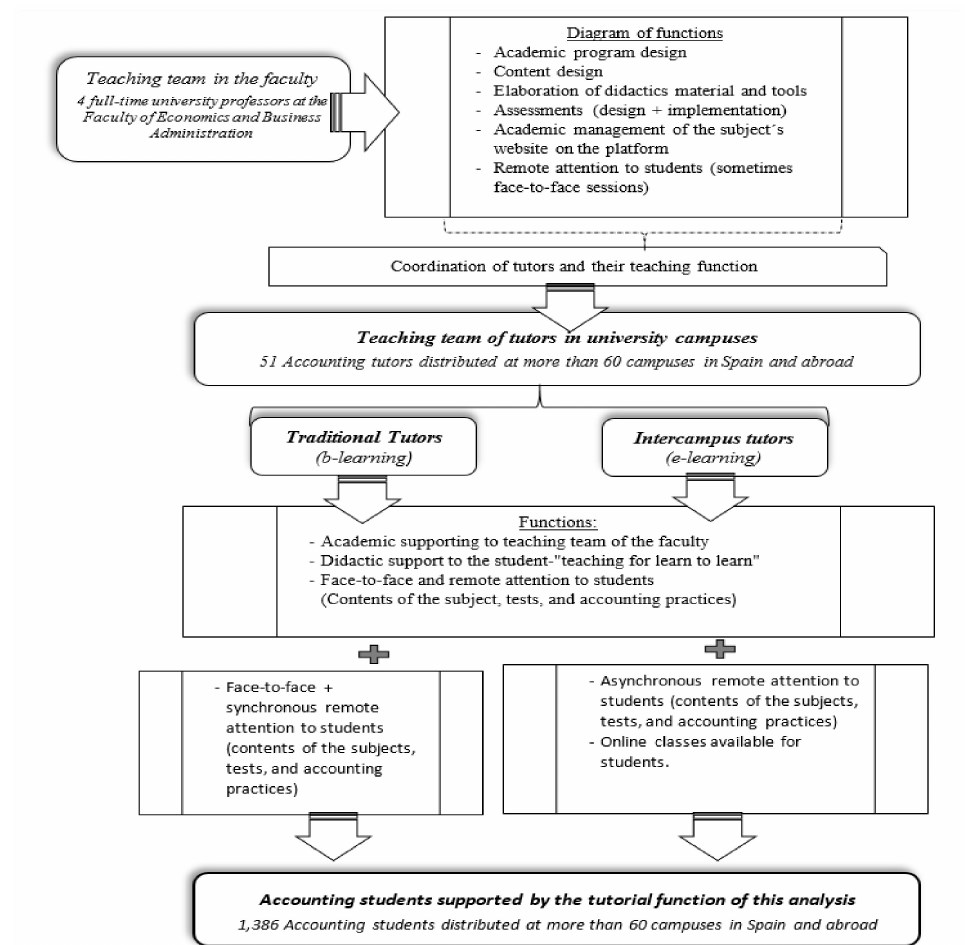
Figure 2. Educational model and tutor function in financial accounting and managerial accounting for tourism at UNED. Source: